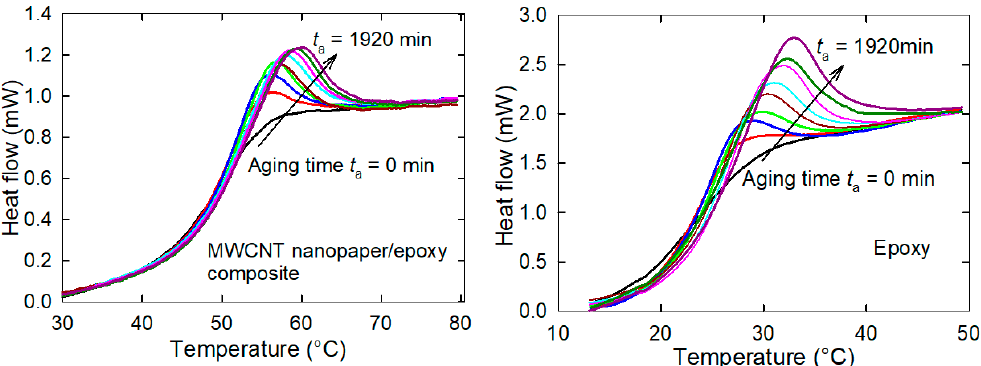
Figure 10. DSC curves for the MWCNT nanopaper/epoxy composite and the pure epoxy obtained when samples were heated after the aging time t a = 0, 15, 30, 60, 120, 240, 480, 960, 1920 min. A stepwise increase in the aging time is indicated by the arrow.